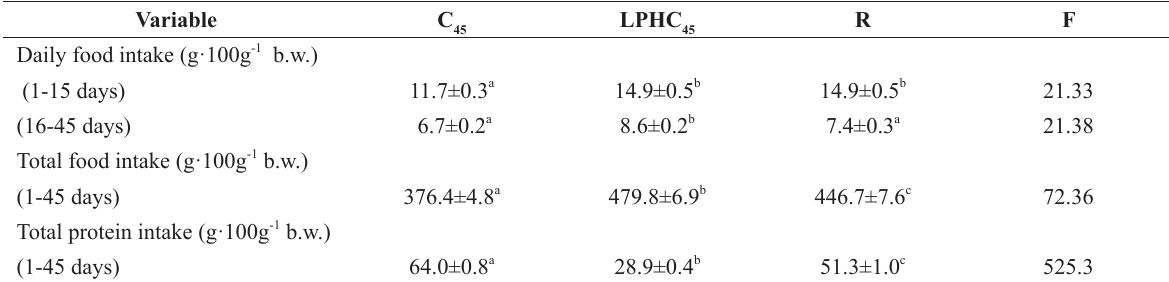
, LPHC , and R rats.* 45 45